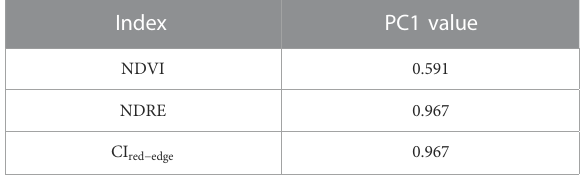
TABLE 2 Three indices of the principal component analysis.